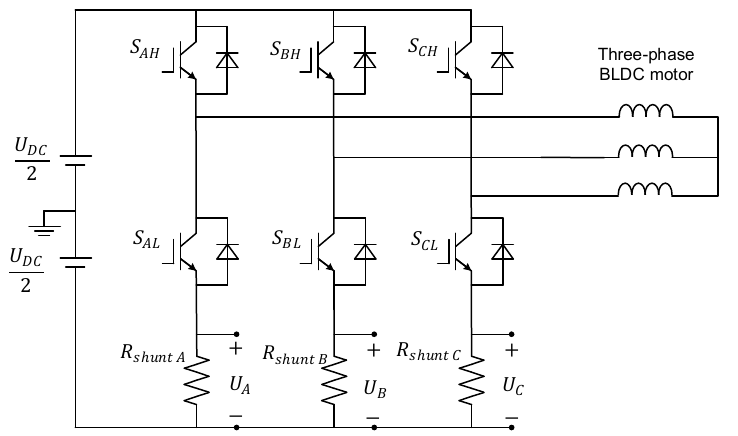
Figure 1. BLDC motor drive. Table 1. Switching patterns of the BLDC motor drive.